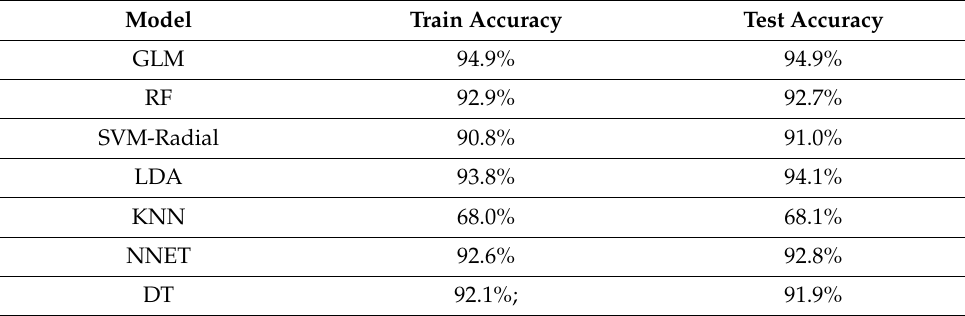
Figure 15. Nodal Demands Distributions (IEEE 118-Bus System). Table 9. Layer-1 Models Performance (IEEE 118-Bus System).